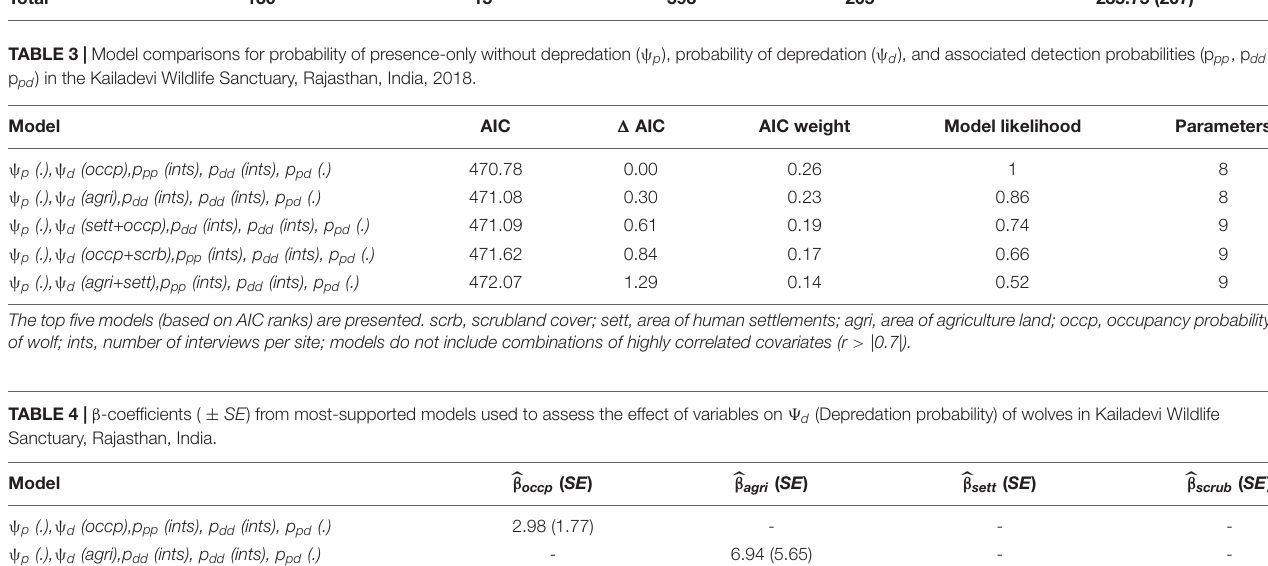
TABLE 2 | Frequency of livestock depredation by wolves across the ranges of Kailadevi Wildlife Sanctuary, Rajasthan, India. Ranges Cattle calf Buffalo calf Goat Sheep Mean livestock depredation Nainyaki